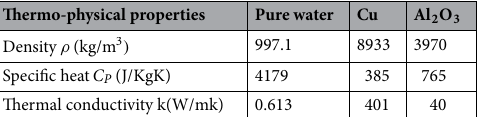
Table 1. Thermo-physical properties of water and nano-particles 43 .